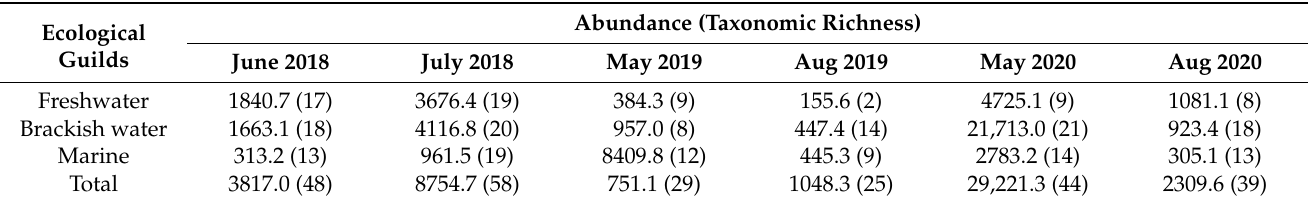
Table 2. Abundance (ind./100m 3 ) and taxonomic richness (no. of taxa) of different ecological guilds sampled during six cruises in the Yangtze Estuary.